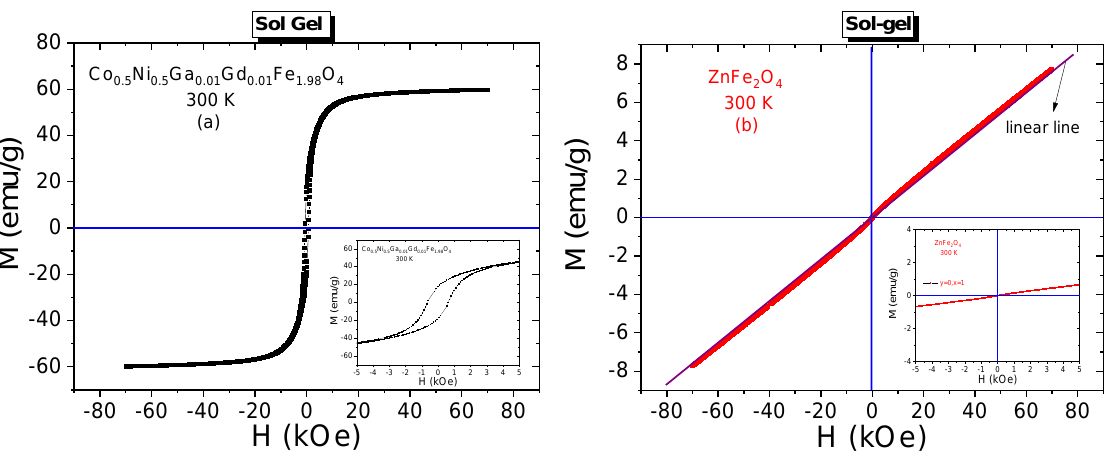
Figure 5. M-H curves recorded at 300 K from ( a ) CNGaGdFO SFNPs and ( b ) ZFO SFNPs synthesized by sol-gel method. Enlarged views were embedded, too.